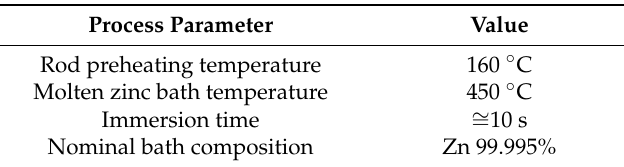
Table 2. Hot-dip galvanizing process